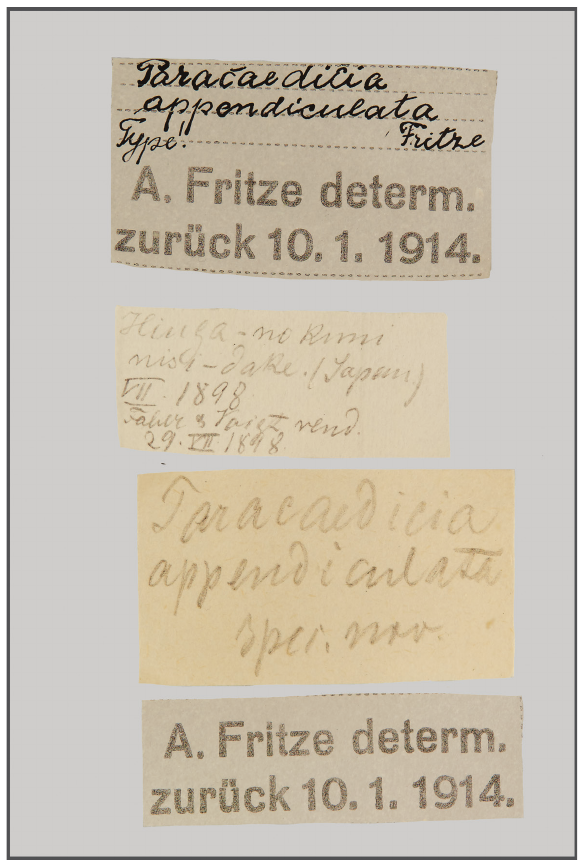
Figure 3. Label of the specimen of unknown status (Fig. 1D) described by Adolf Fritze.